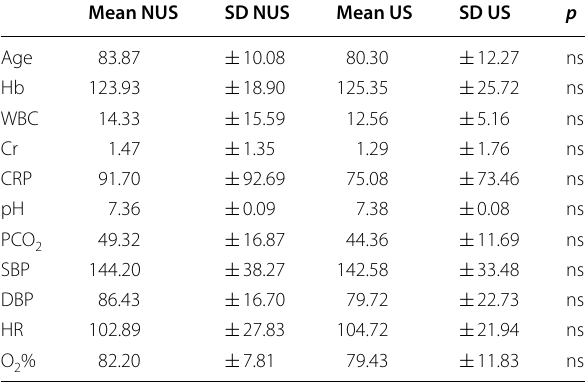
Table 1 General characteristics of the two study